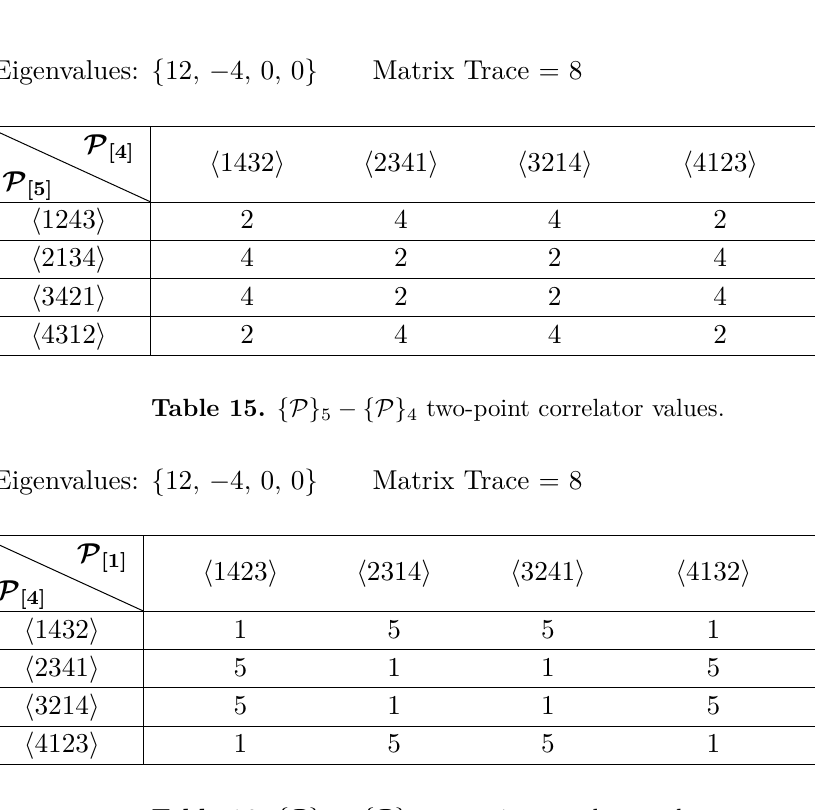
Table 16. {P} 4 − {P} 1 two-point correlator values.